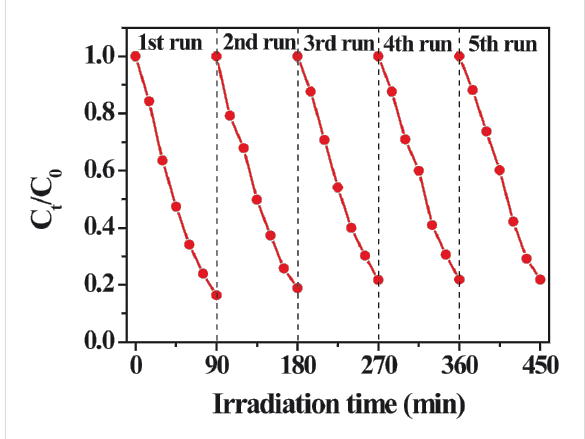
Figure 8: Cycling test of the photocatalytic degradation under visible- light irradiation of a MB aqueous solution in the presence of the Ag 2 CrO 4 sample prepared by microemulsion